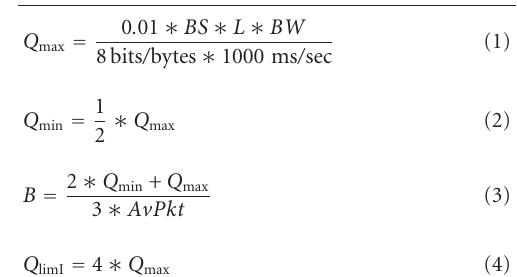
Table 1: Tra ffi c classes by flow. Table 2: GRED queuing.